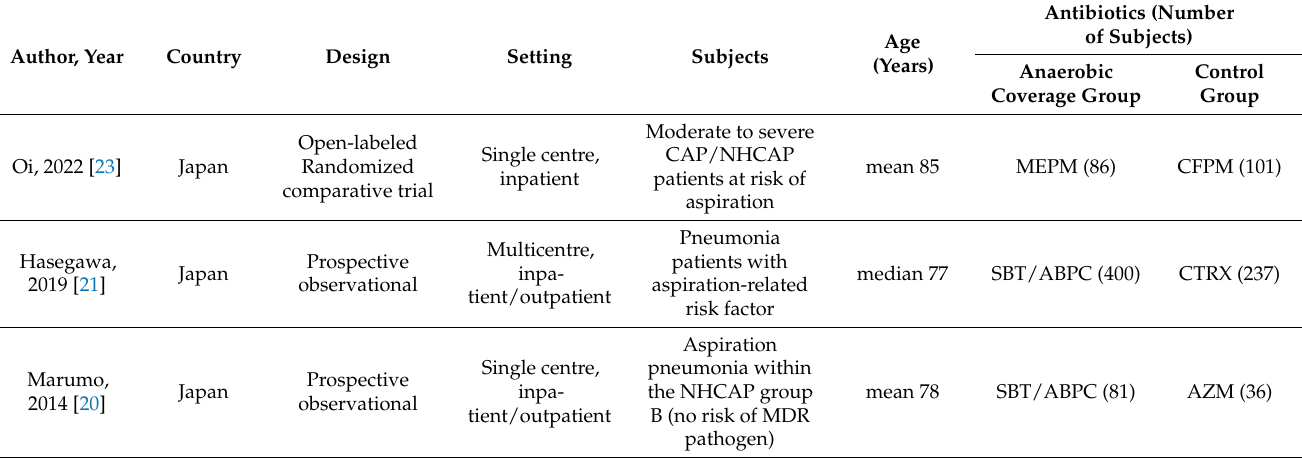
Table 1. Study Table 1. Study Characteristics.